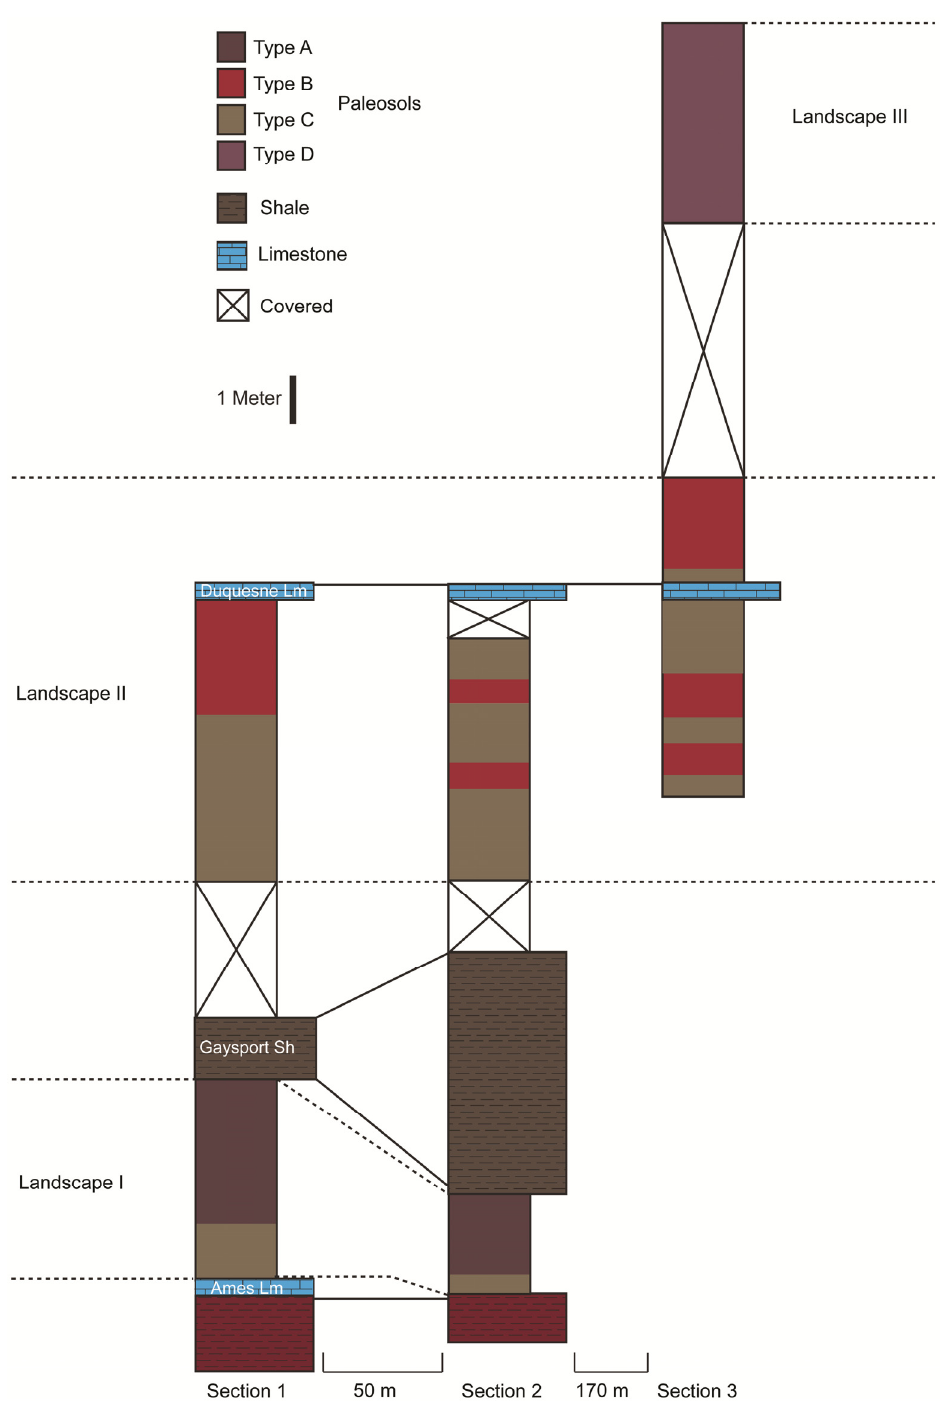
Figure 2. Generalized stratigraphic sections of the Casselman